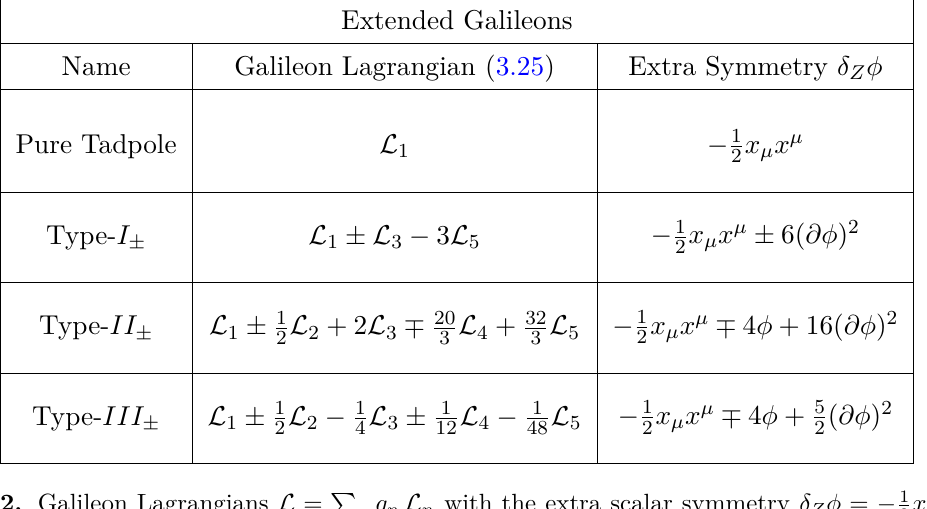
Table 2. Galileon Lagrangians L = P aφ − b ( ∂φ ) 2 / 2 , in units where Λ = 1